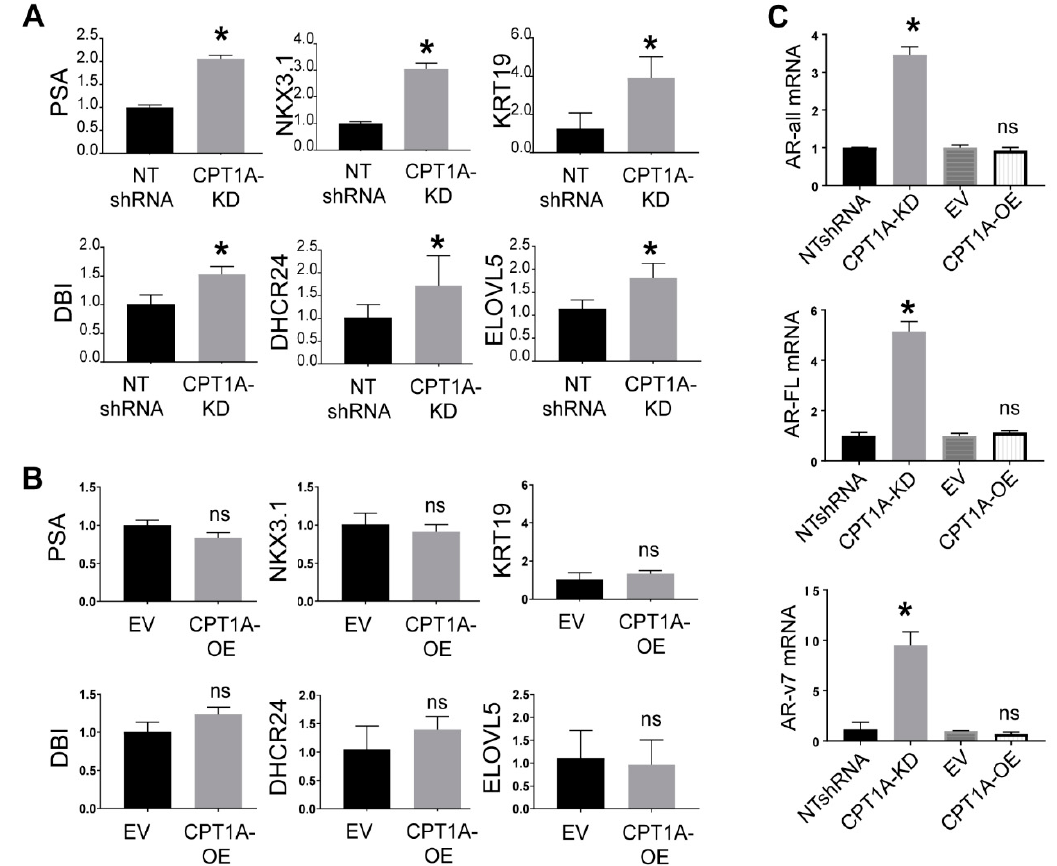
Figure 3. AR response in C4-2 CPT1A -KD and CPT1A -OE cells. ( A ): Basal expression of AR response genes in C4-2 CPT1A -KD and control NTshRNA cells, n = 4 per group; Students t -test. * p < 0.01 vs. control. ( B ): Basal expression of AR response genes in C4-2 CPT1A -OE and control EV cells. Data was normalized to RPL13A mRNA, n = 4 per group, changes were not significant. ( C ): AR mRNA expression in response to DHT. Expression of AR-all (measures all isoforms of AR), ARFL (full length AR) and ARv7 (AR variant v7) was measured in response to 100 pM DHT in CPT1A -OE and control EV cells, n = 4 per group. * p ≤ 0.01 compared with its respective control.